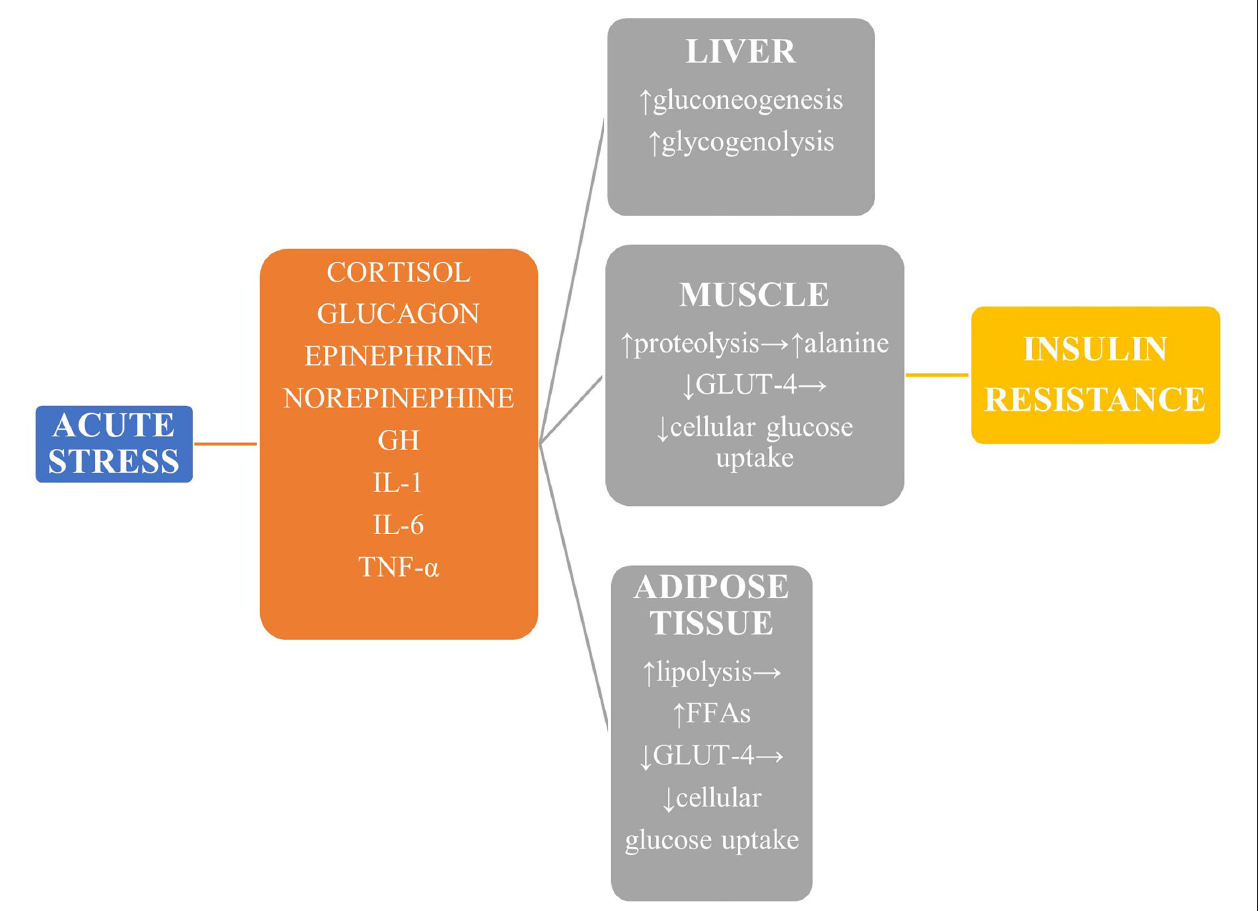
FIGURE 1 | The main mechanisms leading to stress hyperglycemia. Reduced GLUT-4-mediated glucose transport in liver, muscle, and adipose tissue leads to derangement of the insulin-signaling pathway and reduced glucose uptake, while glucose production is upregulated mainly via enhanced gluconeogenesis. GH, growth hormone; TNF- α , tumor necrosis factor α ; GLUT-4, glucose transporter protein